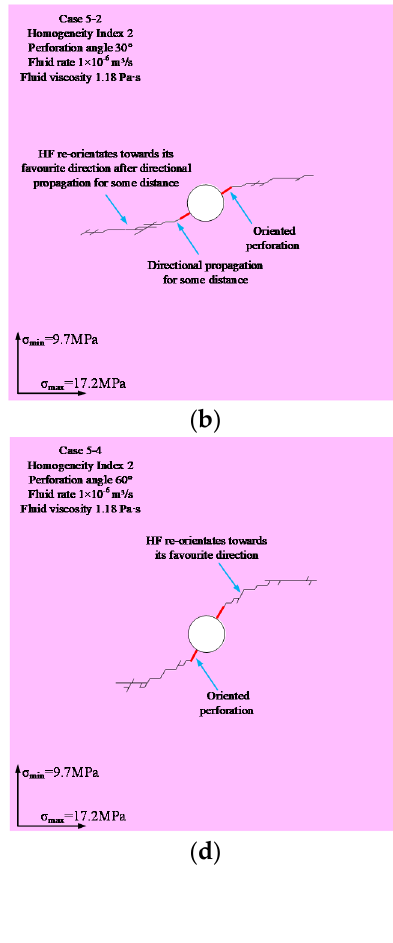
Oriented perforation